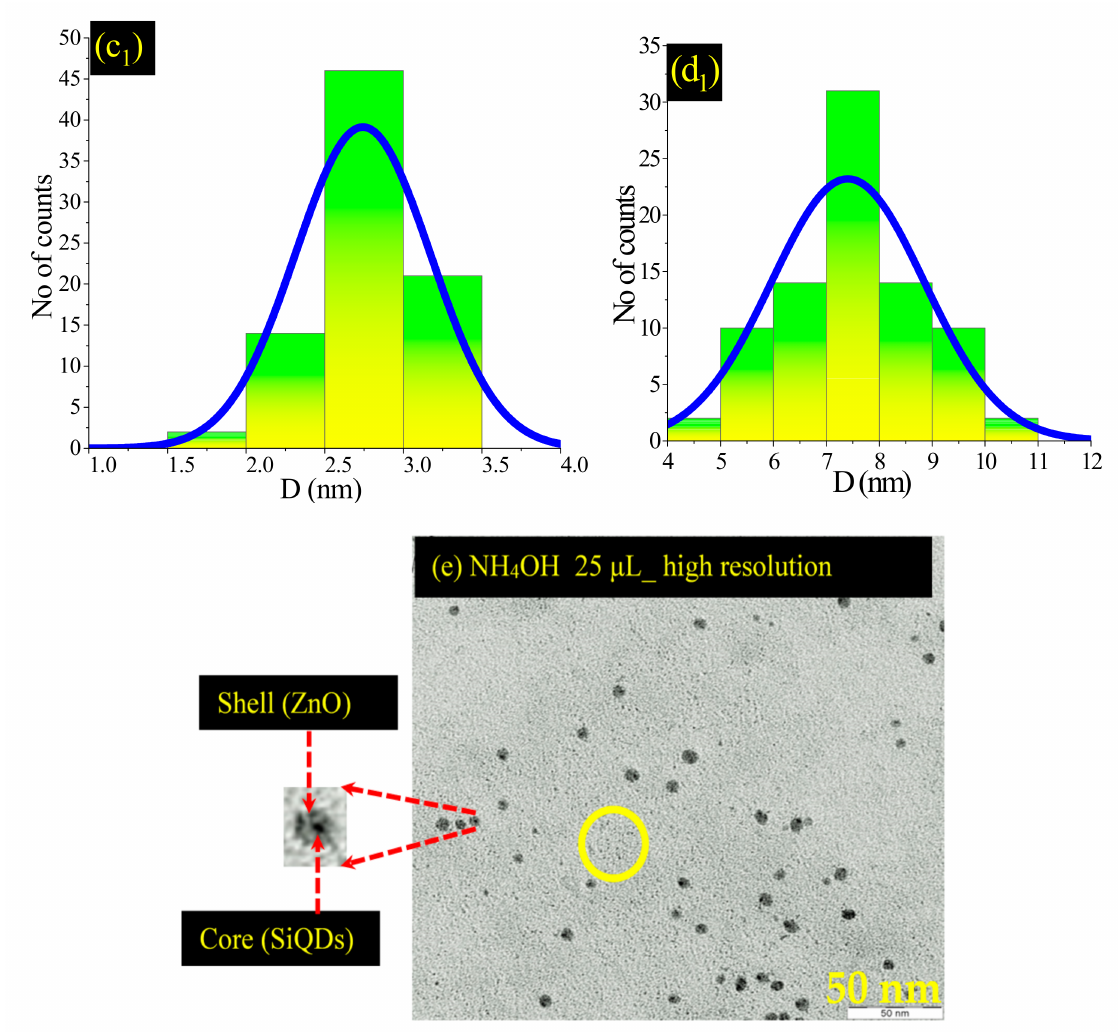
Figure 7. ( a – d ) EFTEM images of the colloidal ZnSiQD suspension in acetone prepared with NH 4 OH of 0, 15, 20, and 25 µ L, respectively. ( a 1 – d 1 ) particle size distributions of the colloidal ZnSiQDs (20 mL) suspended in acetone with NH 4 OH of 0, 15, 20, and 25 µ L, respectively. ( e ) NH 4 OH: 25 µ L high